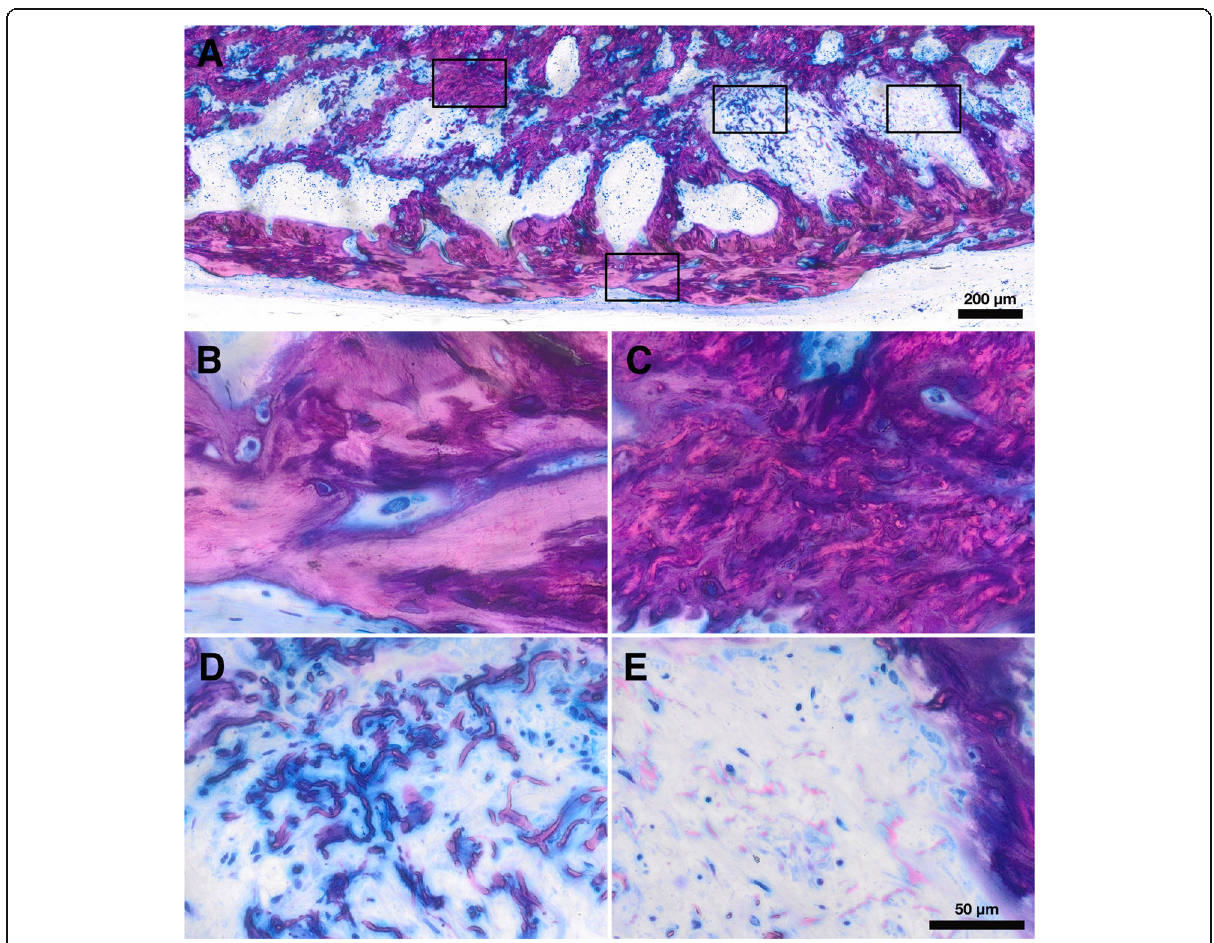
Fig. 5 Histological overview of a defect treated with an upside-down membrane. a, b Bone with collagen. c, d Bone without collagen. e, f Mineralized collagen